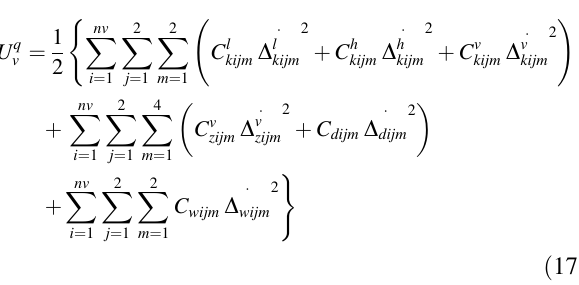
Fig. 9 Maximum of amplitude at middle span (unit: mm). a Lateral, b